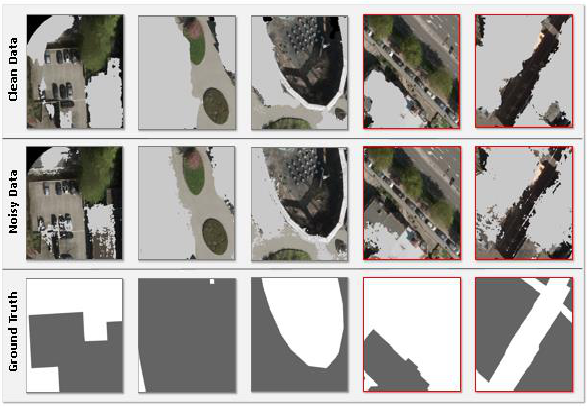
Figure 13. Comparison of building classification result from clean and unclean training samples (grey color represents the bulding area) 4.3.3